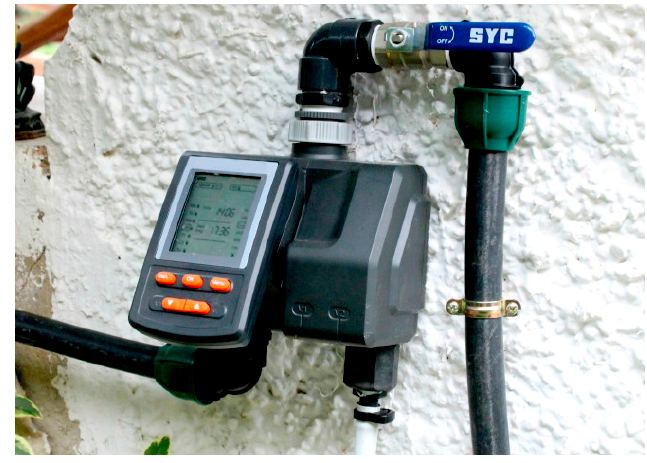
Figura 25. Commercial device used for comparison with the conducted case study. Figure 25. Commercial device used for comparison with the conducted case